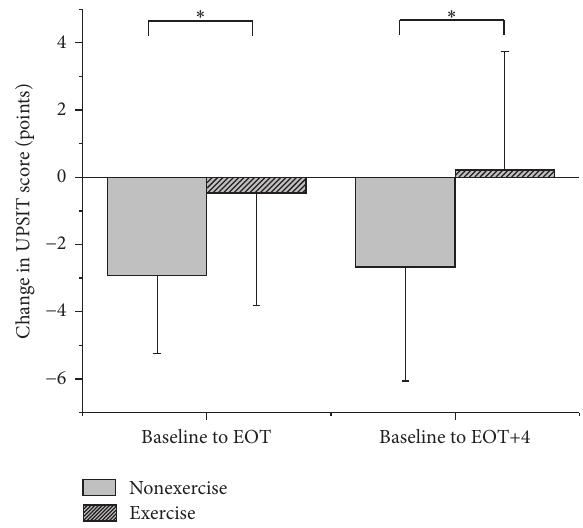
Figure1:MeanchangeinUPSITscoresfrombaselinetoEOT.There was a significant difference (indicated with ∗ ) between the exercise and nonexercise groups in change in UPSIT scores from baseline to EOT and EOT+4, respectively. A positive change in UPSIT score indicates improved odor